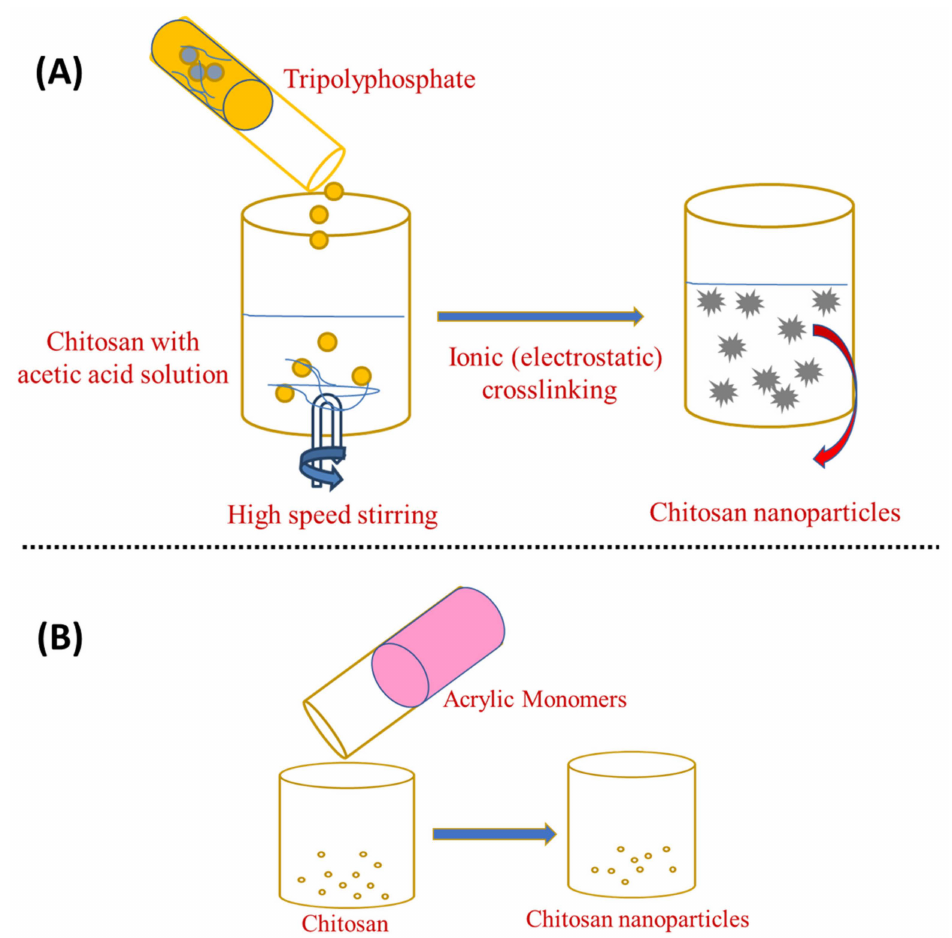
Figure 2. Preparation of chitosan nanoparticles by ( A ) ionotropic gelation and ( B ) ionotropic gelation with the radical polymerisation